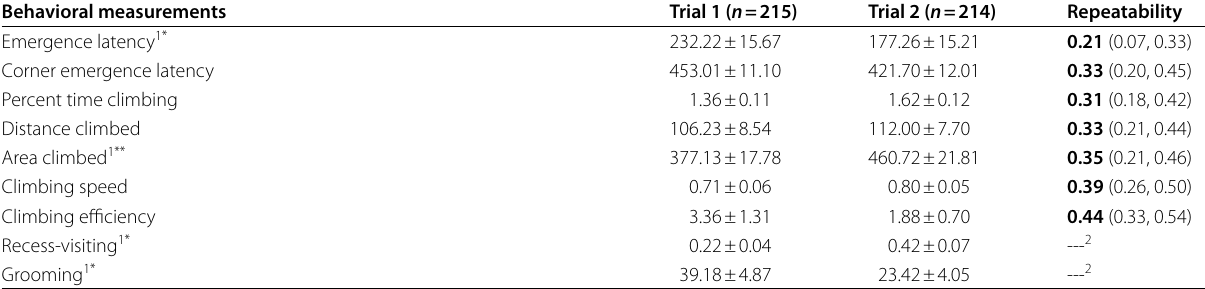
Table 2 Mean (± SE ) behavioral performances and behavioral repeatability (assessed by R value with 95% CI in parenthesis) of eastern bent-wing bats in tunnel-box